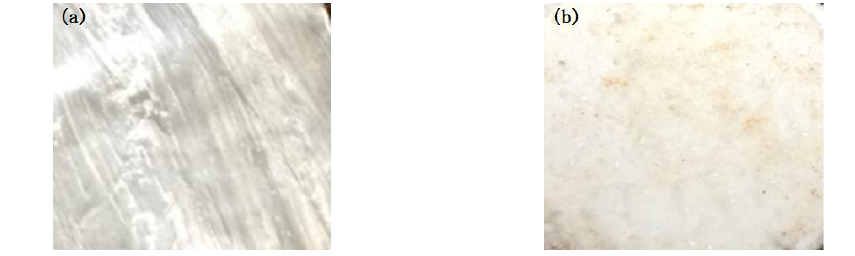
Figure 11. The tensile fracture morphology of sample 3-1: (( a ) aluminum foil; ( b ) DSPE).